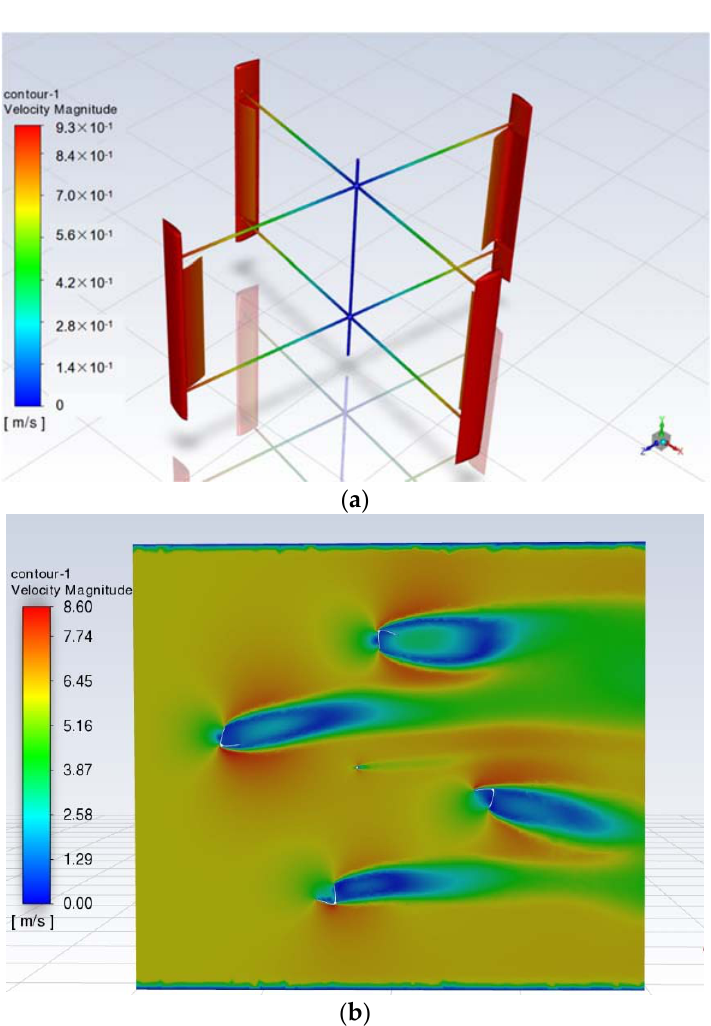
Figure 5. Velocity nephogram. ( a ). wind turbine speed nephogram. ( b ). flow field